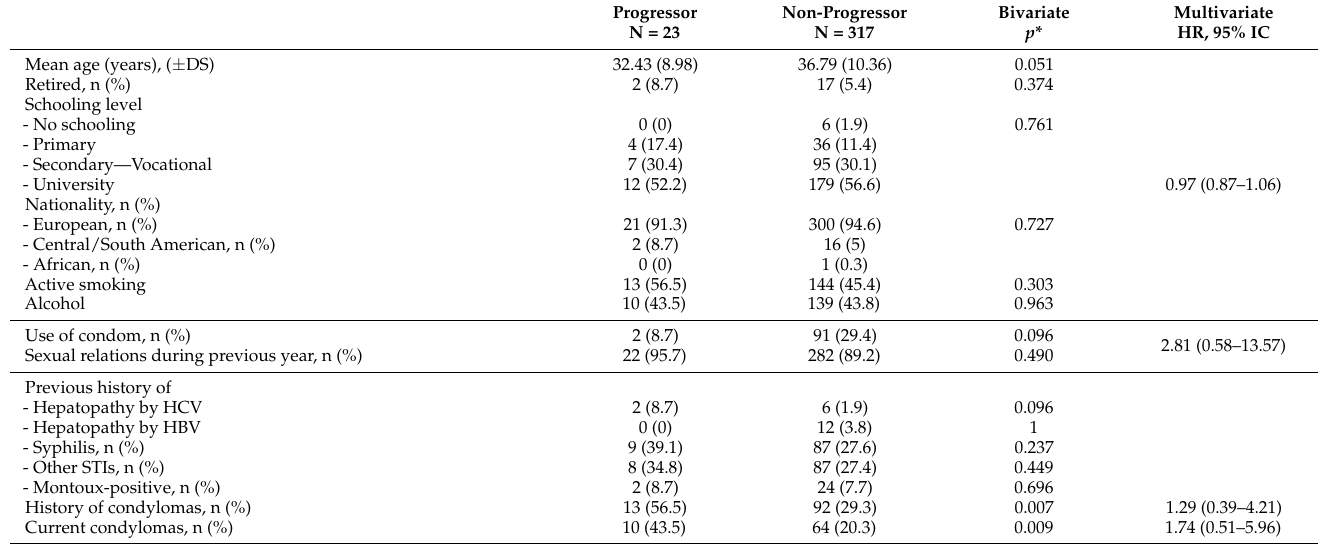
Table 7. Results of bivariate and multivariate